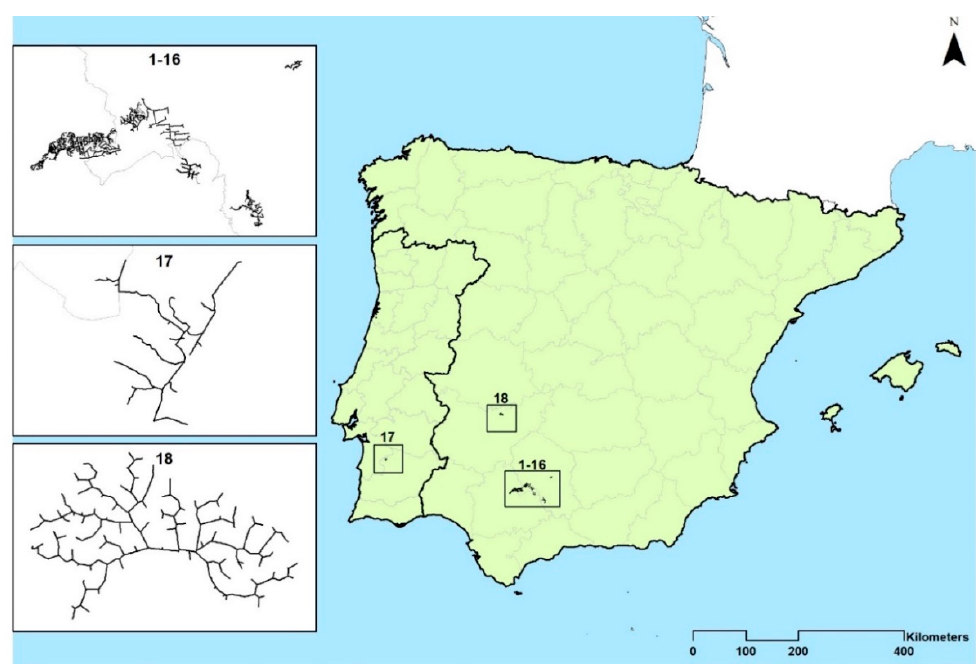
Figure 1. Spatial distribution of 18 irrigation networks analysed in southern Spain and Portugal containing 177 potential locations for MHP energy recovery [30]. The 18 networks are further described in Table 5.